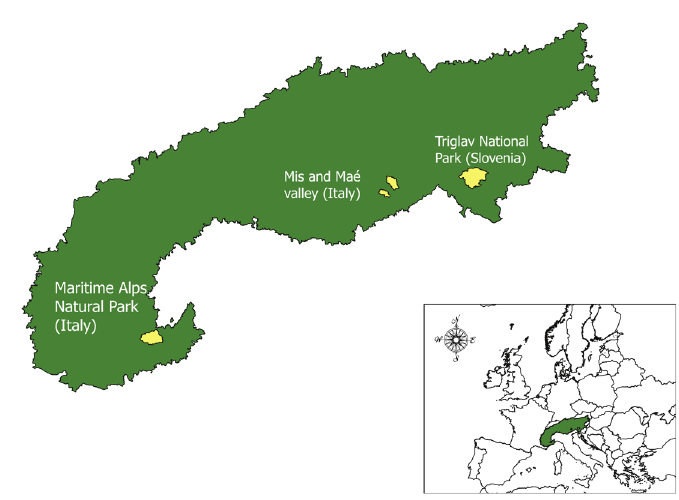
FIGURe 1. Geographical loca- tion of the study areas in the Alpine Region (source: Alpine Convention, SOIA database for alpine perimeter, EU- ROGEOGRAPHICS for admini- strative